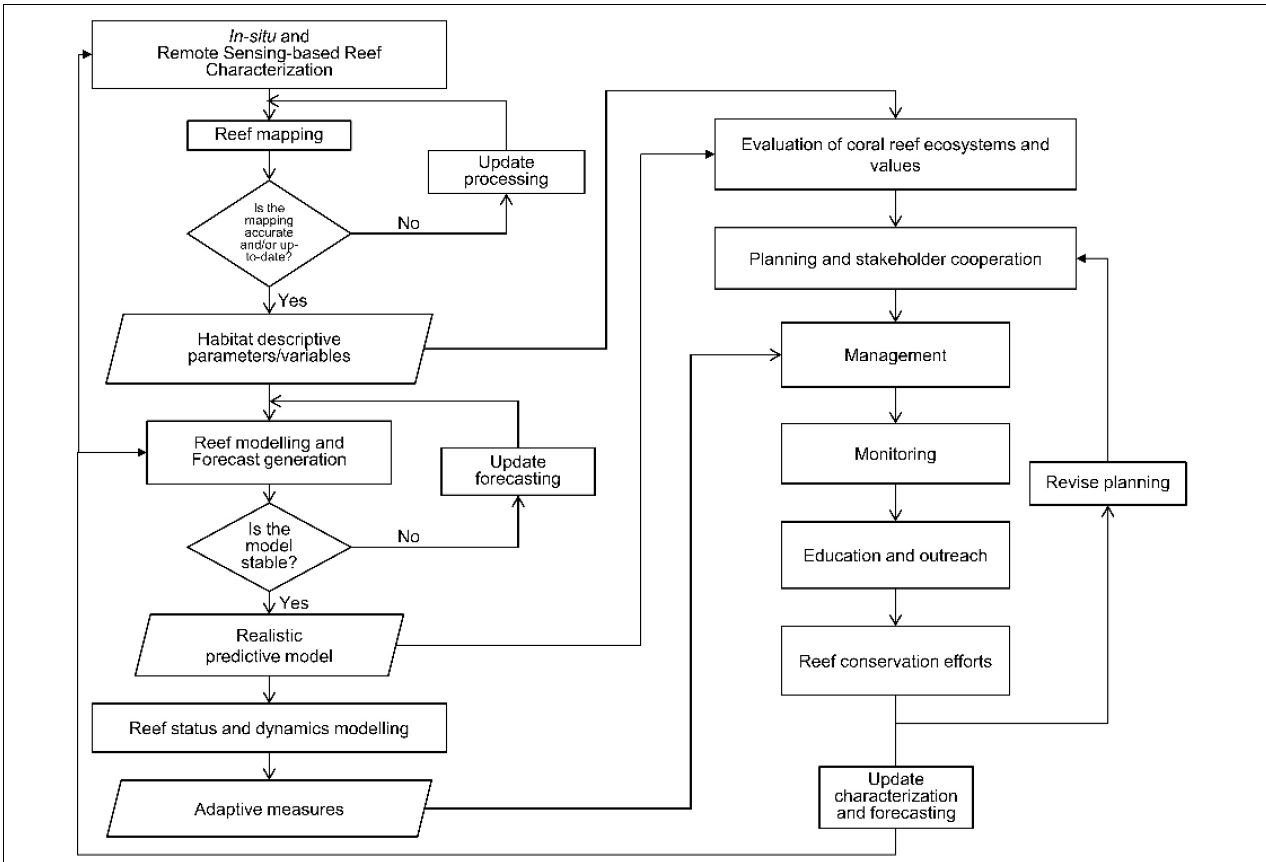
FIGURE 5 | Proposed reef management practice emphasizing the role of science in support of reef-based management and sustainability.